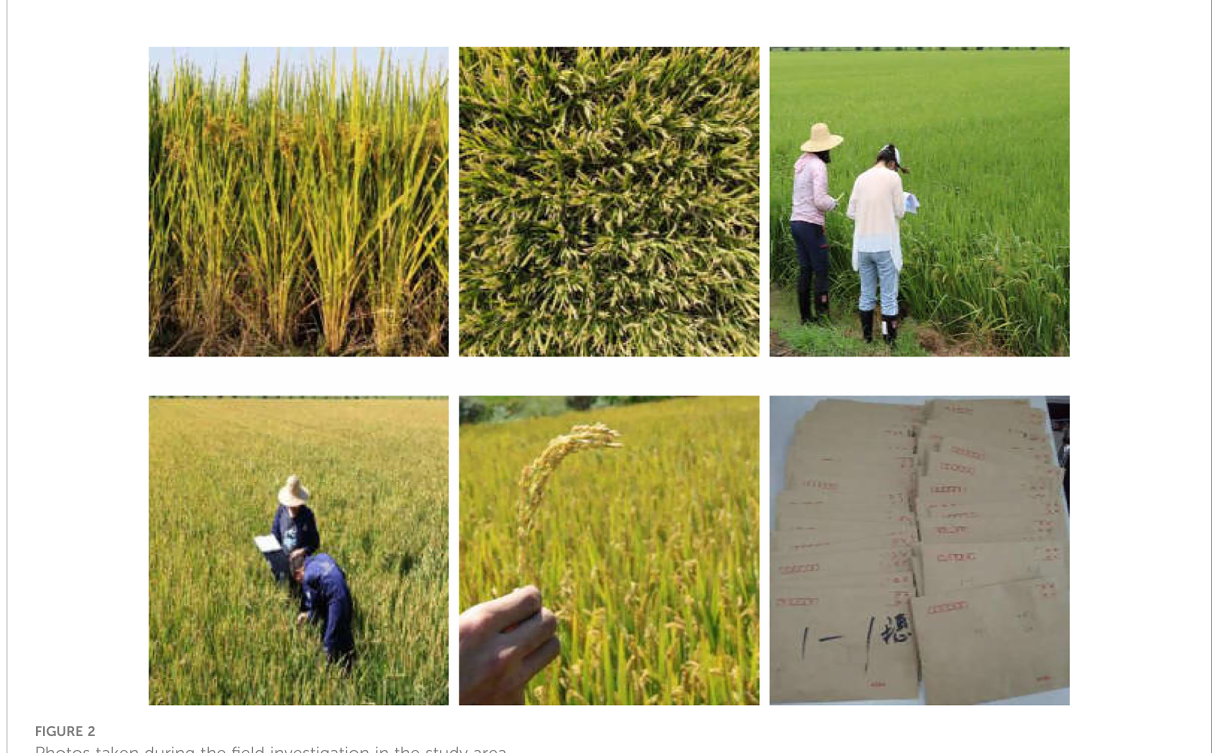
FIGURE 2 Photos taken during the fi eld investigation in the study area.